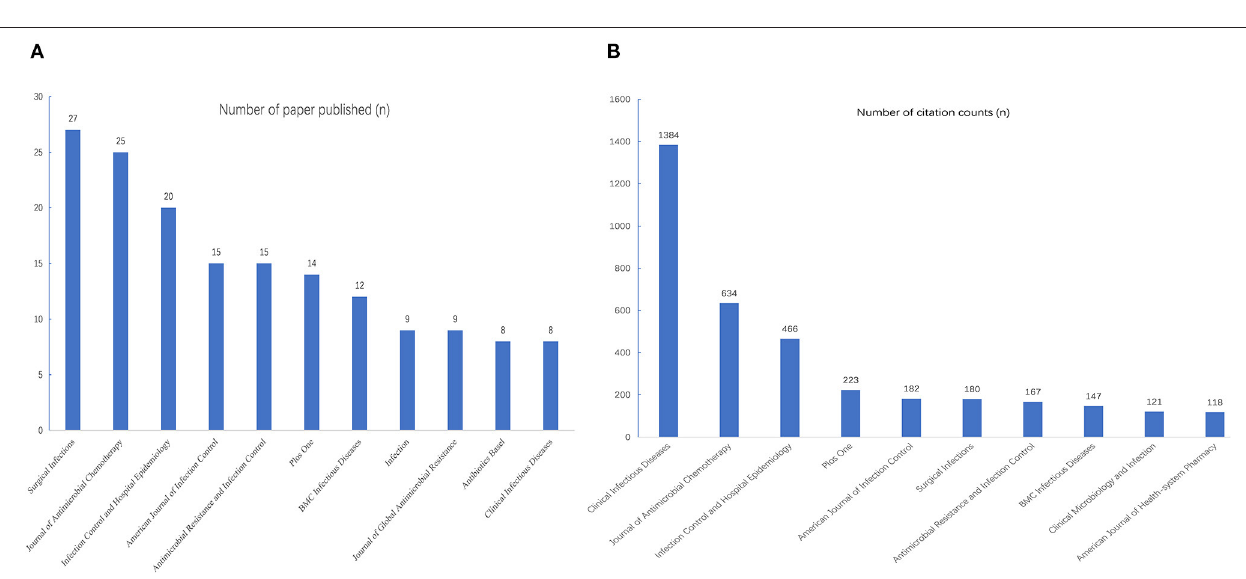
the representative journal Infection Control and Hospital Epidemiology (link strength of 17,573,632 citations) was highly significant